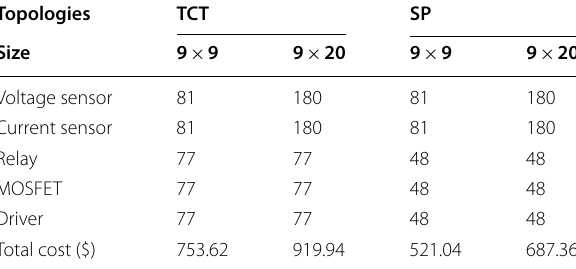
Table 6 Components considered for each